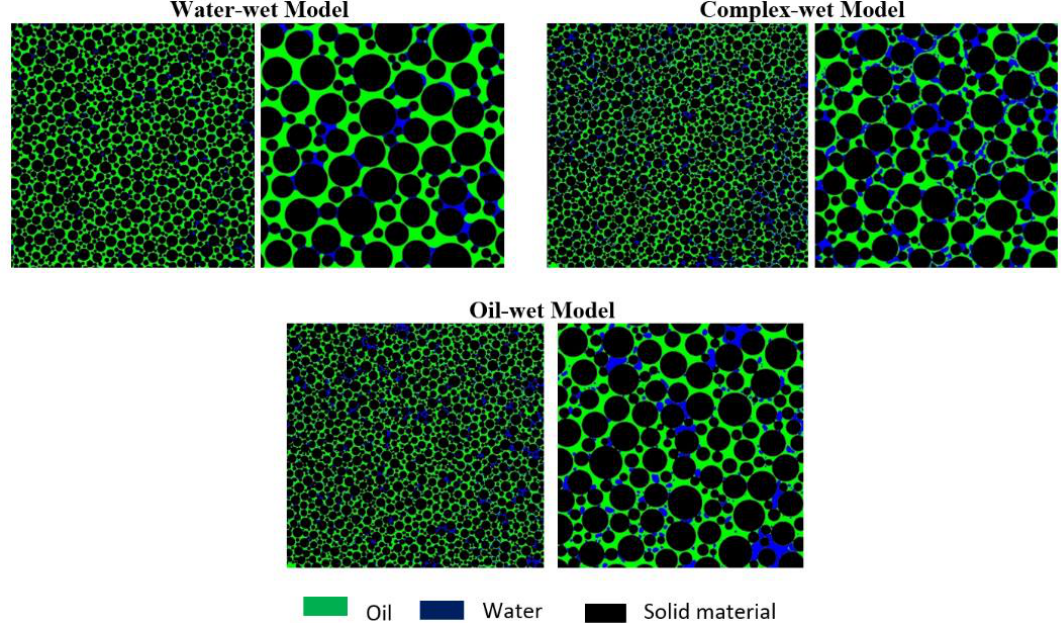
Figure 6. Micromodel with different wettability conditions. Left:each wettability condition represents the micromodel; right zoomed image of the bottom right corner for each micromodel.